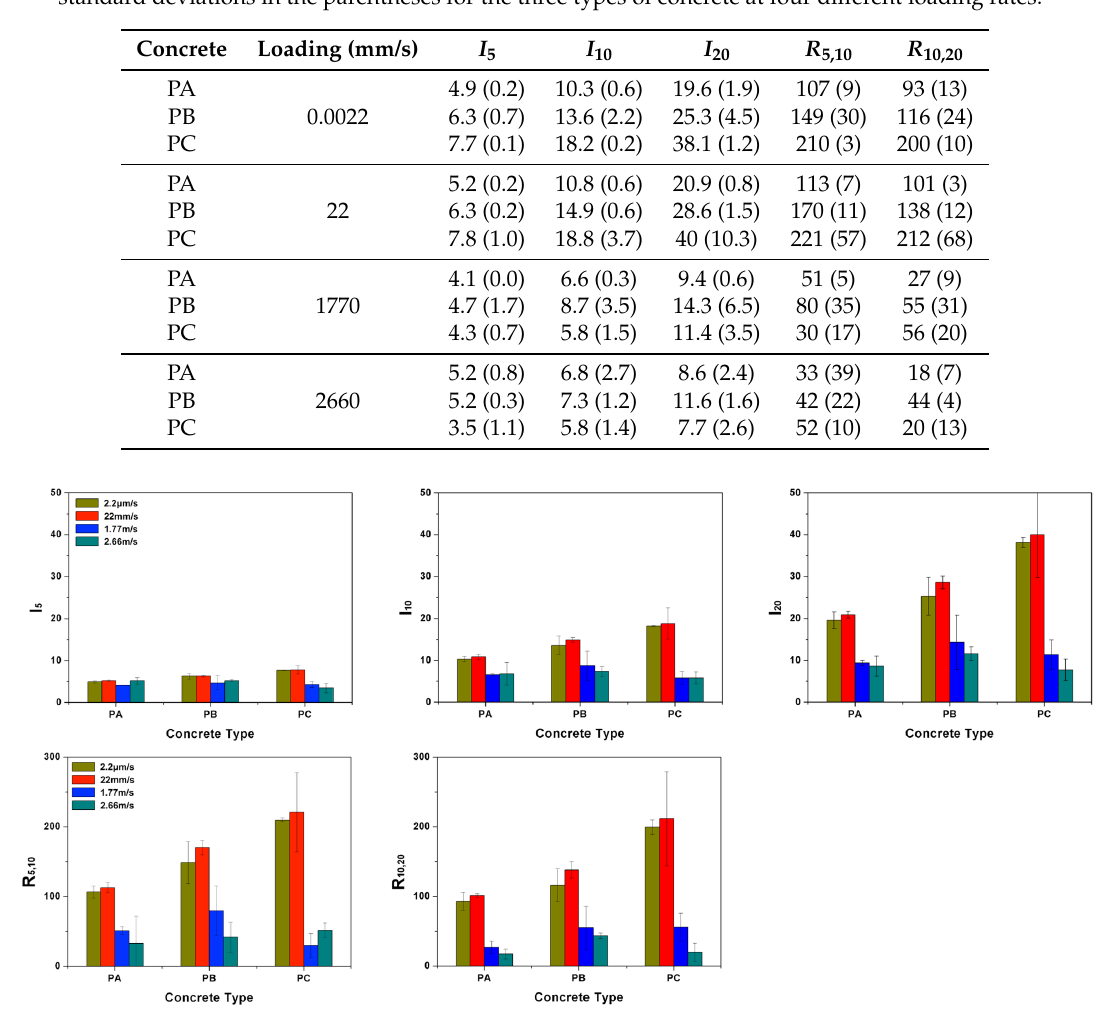
Figure 11. The toughness indices, I 5 , I 10 , I 20 , and the residual strength factors, R 5,10 and R 20,10